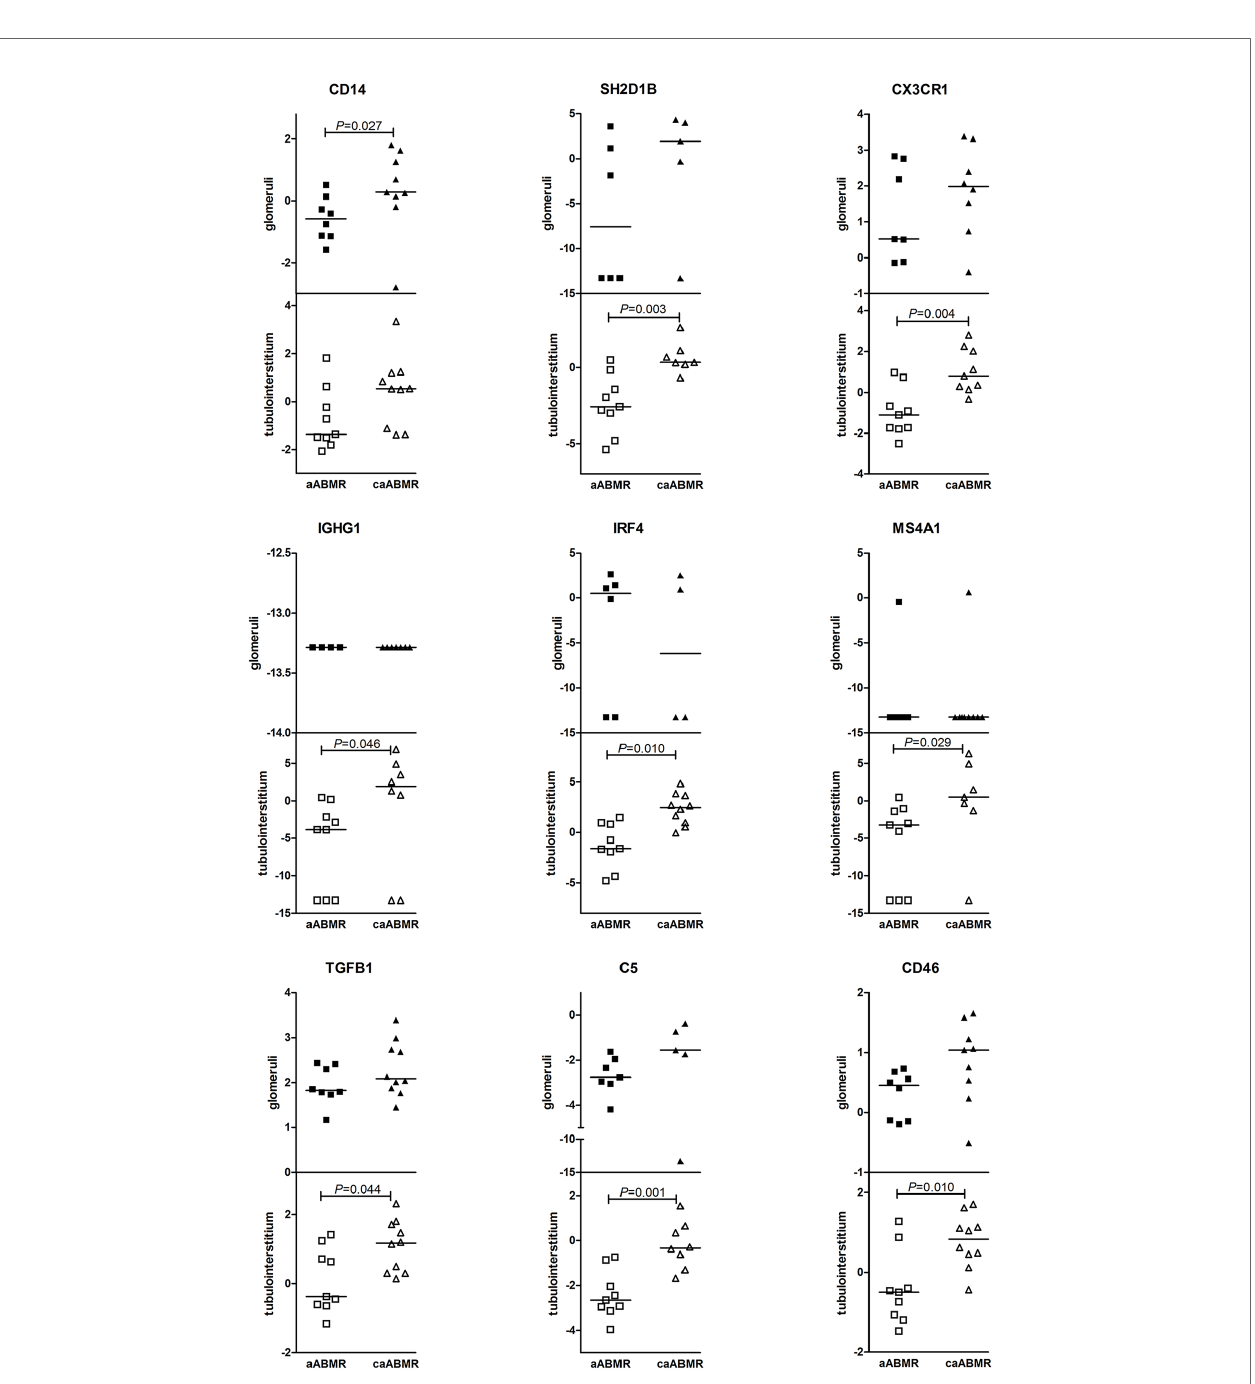
FIGURE 2 | Differences in gene expression (log2 FC) between active ABMR (aABMR) and chronic active ABMR (caABMR) in glomeruli (dark marks) and tubulointerstitium (empty marks). Differences are calculated by Mann-Whitney